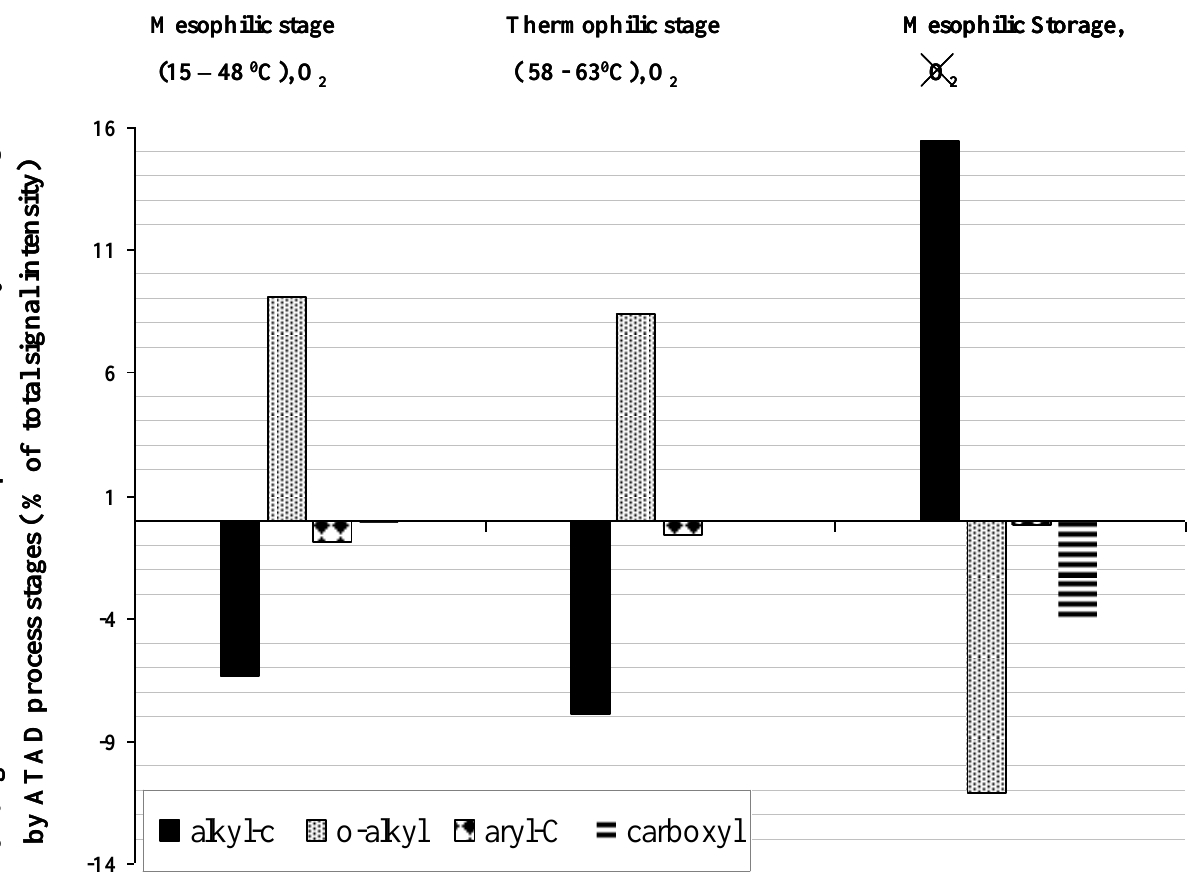
Figure 3. Specific transformation of different C-domains observed by solid-state 13 C Cross Polarization (CP) nuclear magnetic resonance (NMR) and spectral intensities of the sludge samples collected at different stages of the ATAD process. Operating conditions relating to oxygen and temperature ranges during the ATAD processing steps are shown on the top of the plot. The mean values of the data utilized to perform comparison are presented in Table 4 and calculation carried out as recommended by Smernik et al. [20,21] and described in section ―Materials and Methods‖. Mesophilic stage (15 – 48 0 C), O